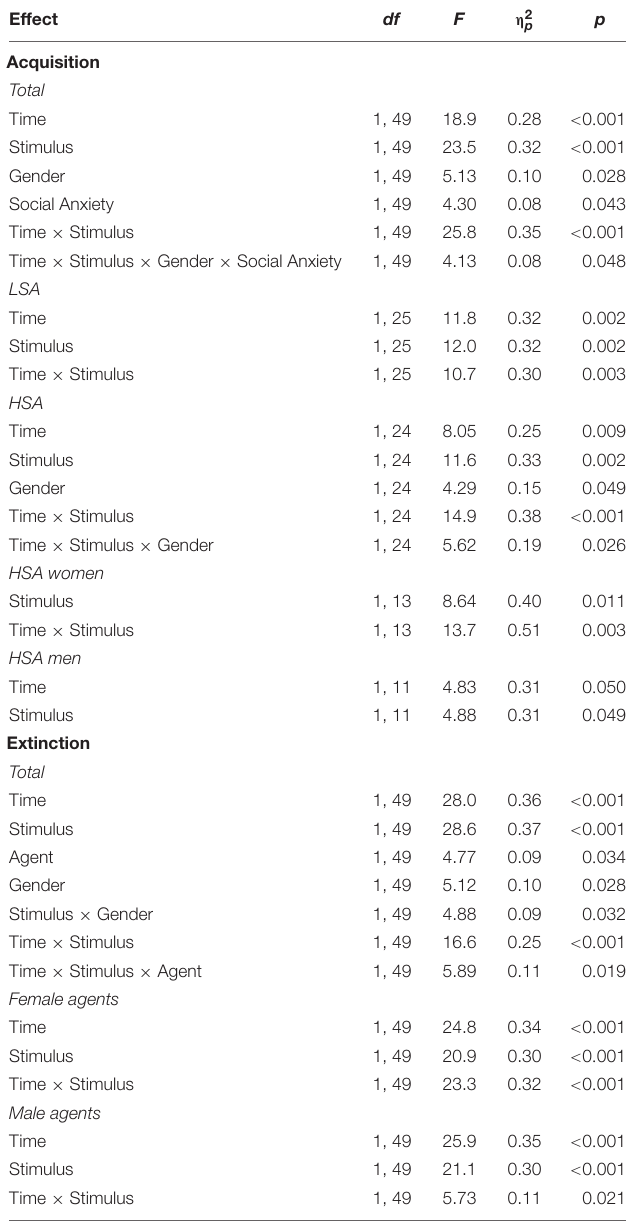
TABLE 2 | Significant results of the ANOVA for fear ratings of the acquisition and extinction